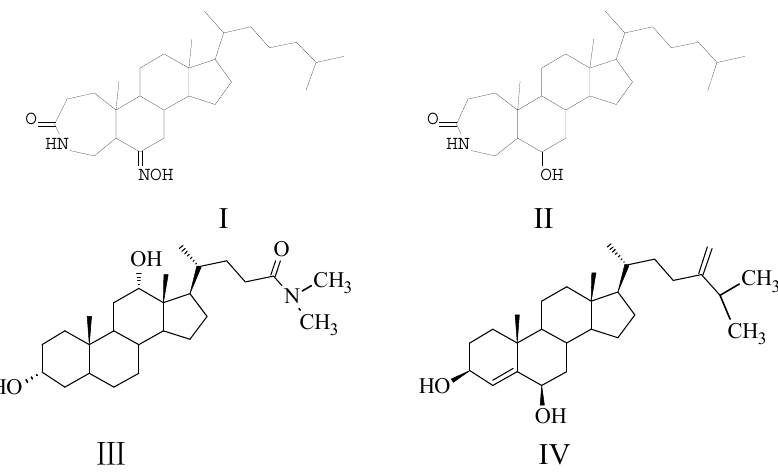
Figure 1. The structure of compounds